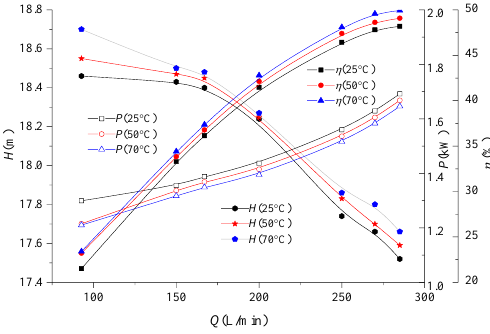
Figure 9. Performance curves of ECWP with different temperatures.